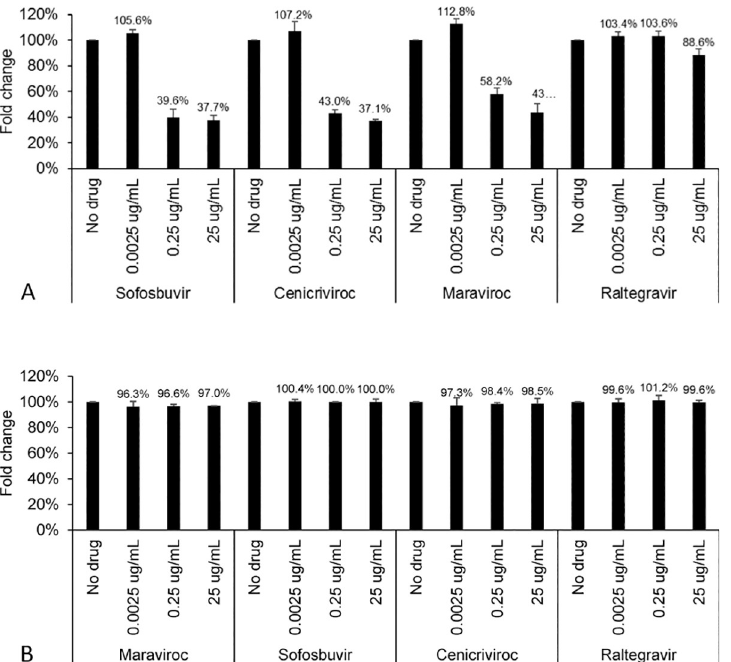
Fig 1. Antiviral effects on Huh7.5 JFH1 cells. Cells were exposed to 0–25 ug/mL of sofosbuvir, cenicriviroc, maraviroc, or raltegravir for 24 hours. (A) HCV core protein production was quantified by ELISA in supernatants at day 1 post- incubation. Using replicates as a blocking variable and combining drug/dose by fold-change, overall mean score difference based upon rank scores using Cochran-Mantel-Haenszel statistic, p = 0.038. Two-way ANOVA using replicate as block variable, demonstrates significant differences by drug, dose, and drug x dose (p < 0.001). (B) Cell number was determined for each experimental condition. No significant differences by drug or dose were observed.